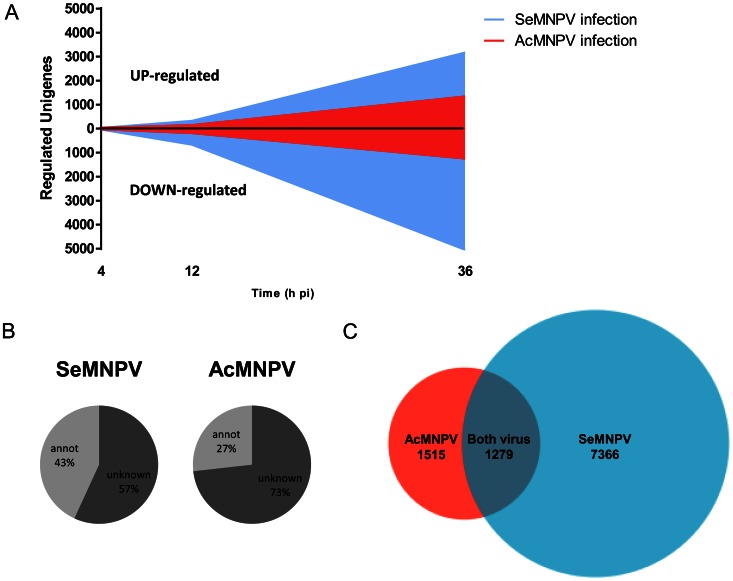
Gene expression patterns of S. exigua Se301 cells infected with SeMNPV and AcMNPV viruses, determined by microarray analysis.(A) Number of up- and down-regulated unigenes at 4, 12 and 36 h after treatment. (B) Percentage of baculovirus-regulated S. exigua unigenes that show homology to known or annotated genes available in public databases. Annot – known or annotated genes; Unknown – genes of unknown description. (C) Common and virus-specific unigenes regulated after treatment with SeMNPV and AcMNPV. In all panels only unigenes that show fold-changes higher than 2 (and p-value<0.05) are included.